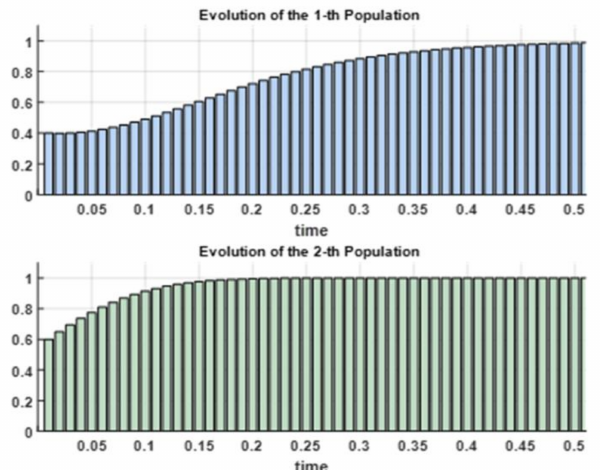
Figure 4. Evolution path of the system under anarchic